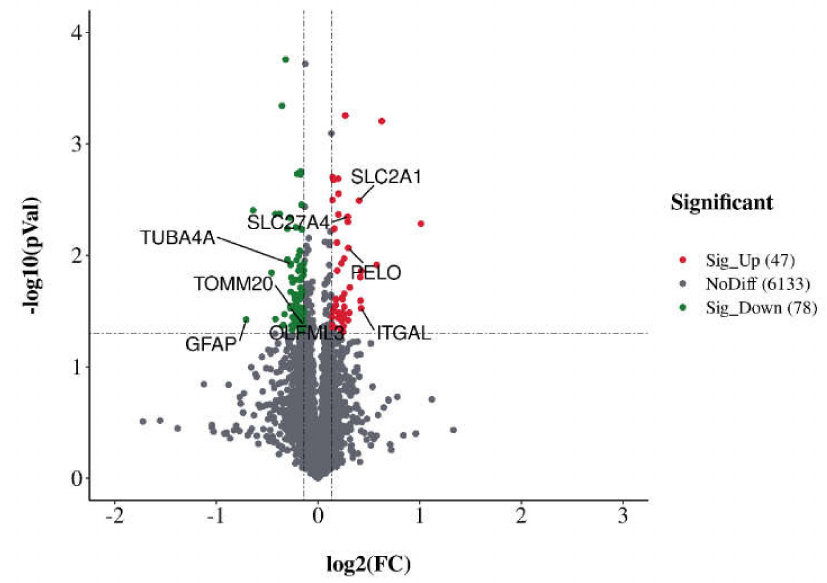
Figure 1. Volcano map of differentially expressed proteins. Proteins with fold change values >1.1 or <0.91 and p < 0.05 were considered to be significantly differentially expressed. Red circles indicate significantly upregulated proteins, green circles indicate significantly downregulated proteins and grey circles indicate proteins with no difference. The x-axis indicates the fold change, and the y-axis indicates the p value.